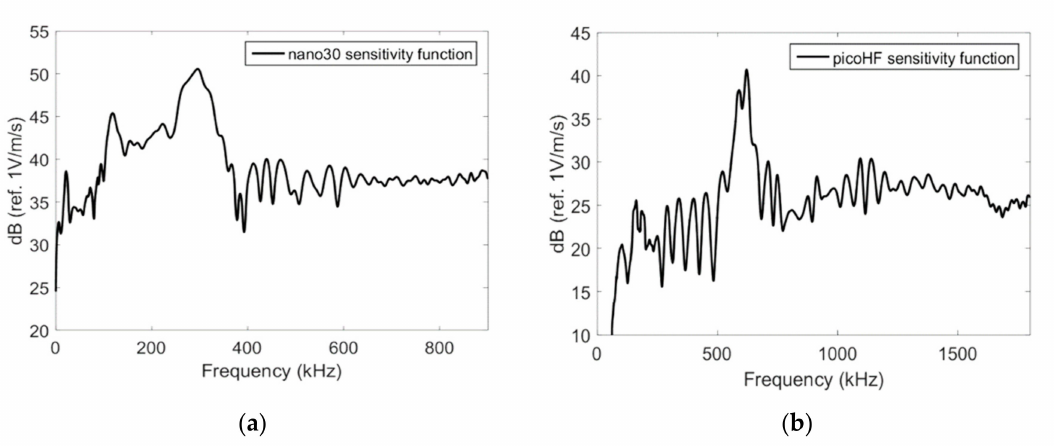
Figure 4. Response in reception on steel block for the Nano30 ( a ) and PicoHF ( b ) sensors obtained with the reciprocity